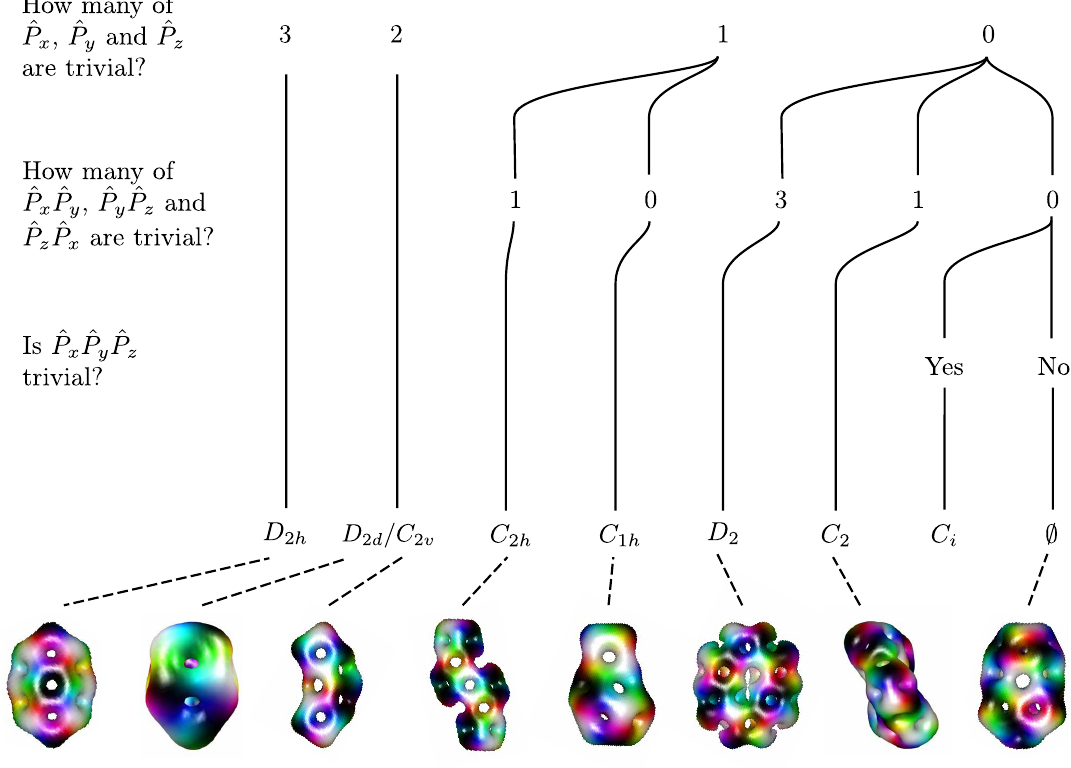
Figure 1. A procedure to calculate the symmetry group of a given solution. An example of a Skyrmion with that symmetry group is given, where